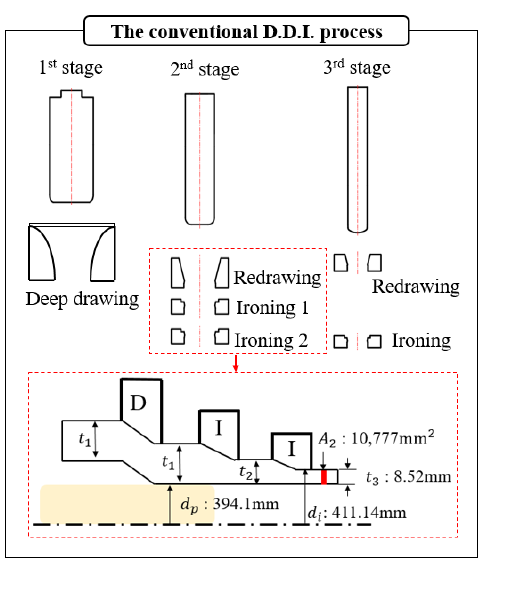
Table 7. Calculation of reduction rate of cross sectional area (RA) in the 3rd stage.